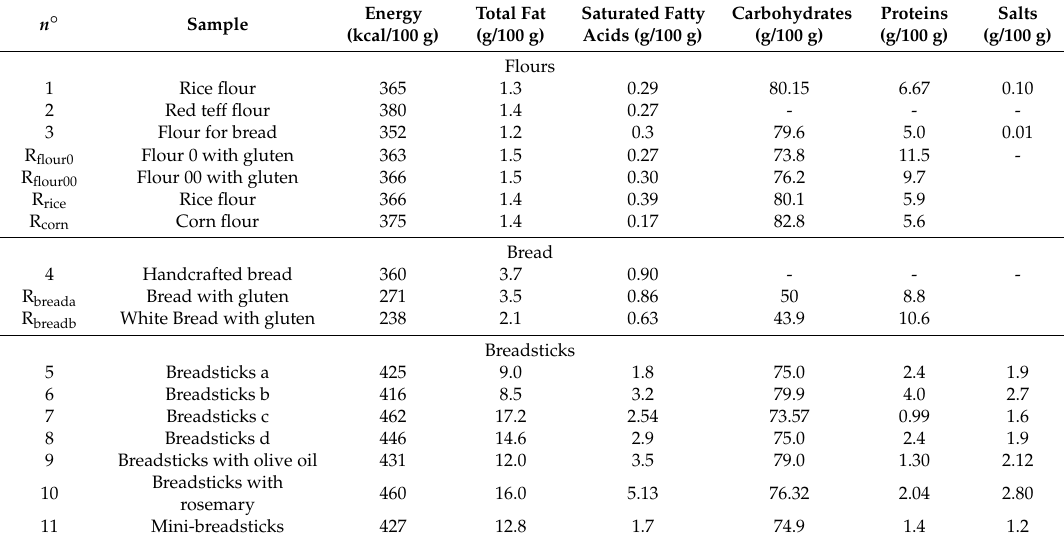
Table 1. Nutritional characteristics of the analyzed gluten-free samples and reference food (Rx). n